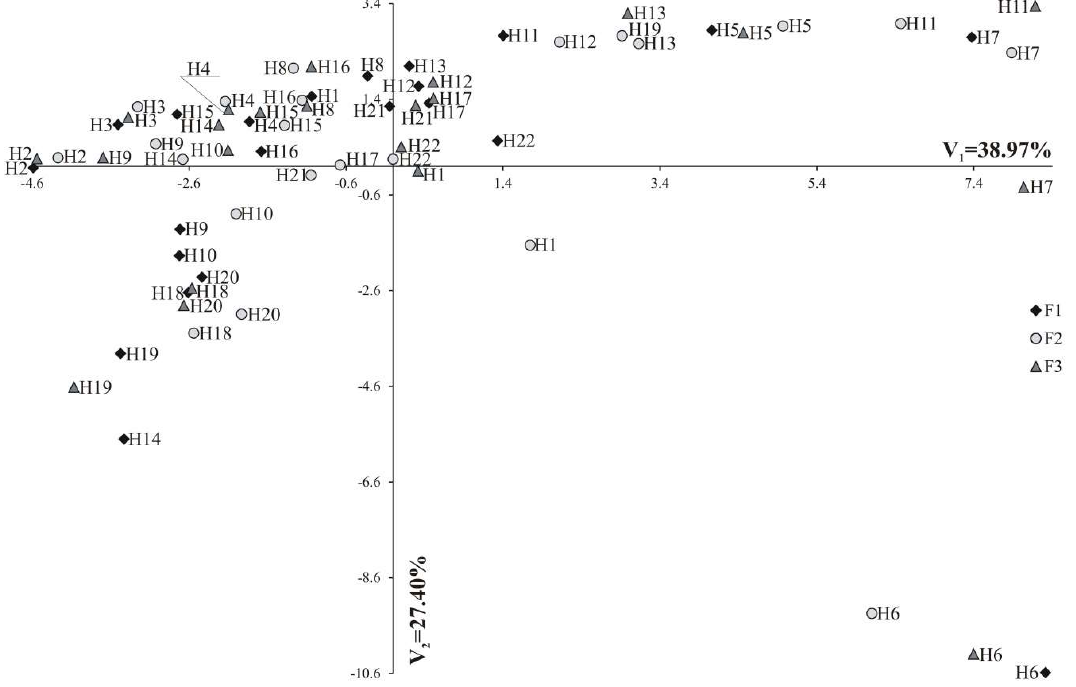
Figure 3. Location of Brassica hybrids in the system of the first two canonical variables.